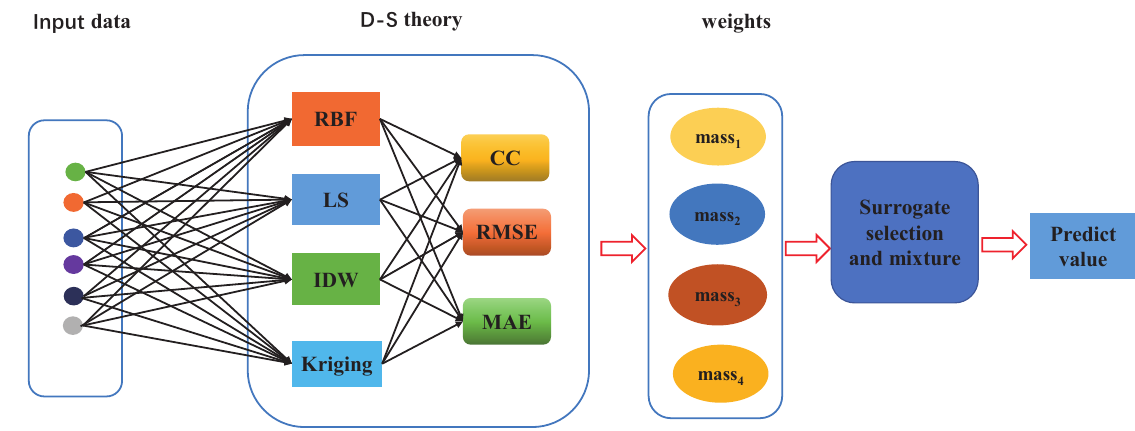
Figure 2. D-S theory weighted evaluation of surrogate model steps.